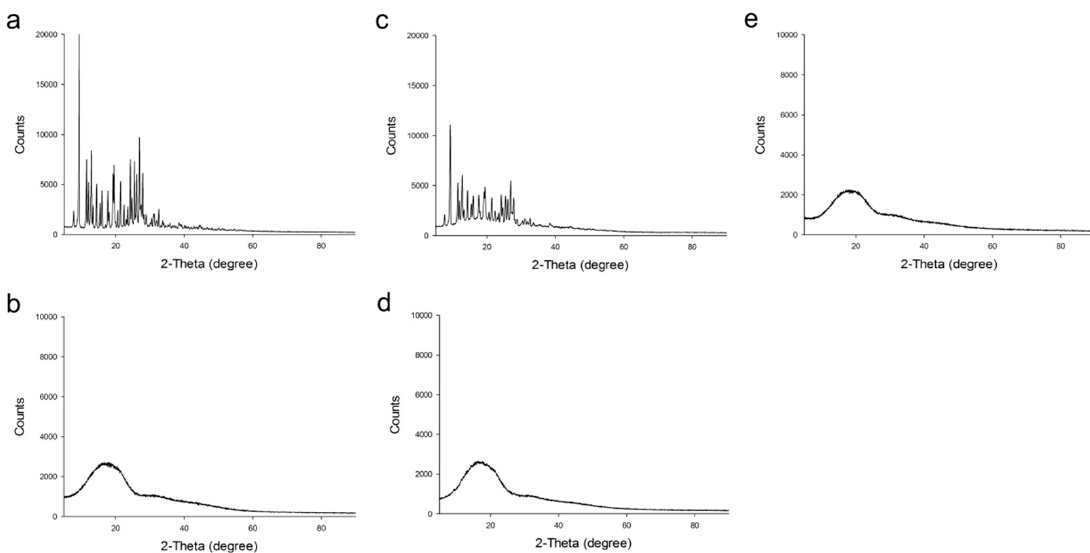
Figure 3. X-ray di ff raction (XRD) patterns of MTX ( a ), PLGA ( b ), physical mixture of MTX / PLGA ( c ), Figure 3. X-ray diffraction (XRD) patterns of MTX ( a ), PLGA ( b ), physical mixture of MTX/PLGA ( c ), blank NPs ( d ), and MTX-loaded PLGA NPs ( e blank NPs ( d ), and MTX-loaded PLGA NPs ( e ).